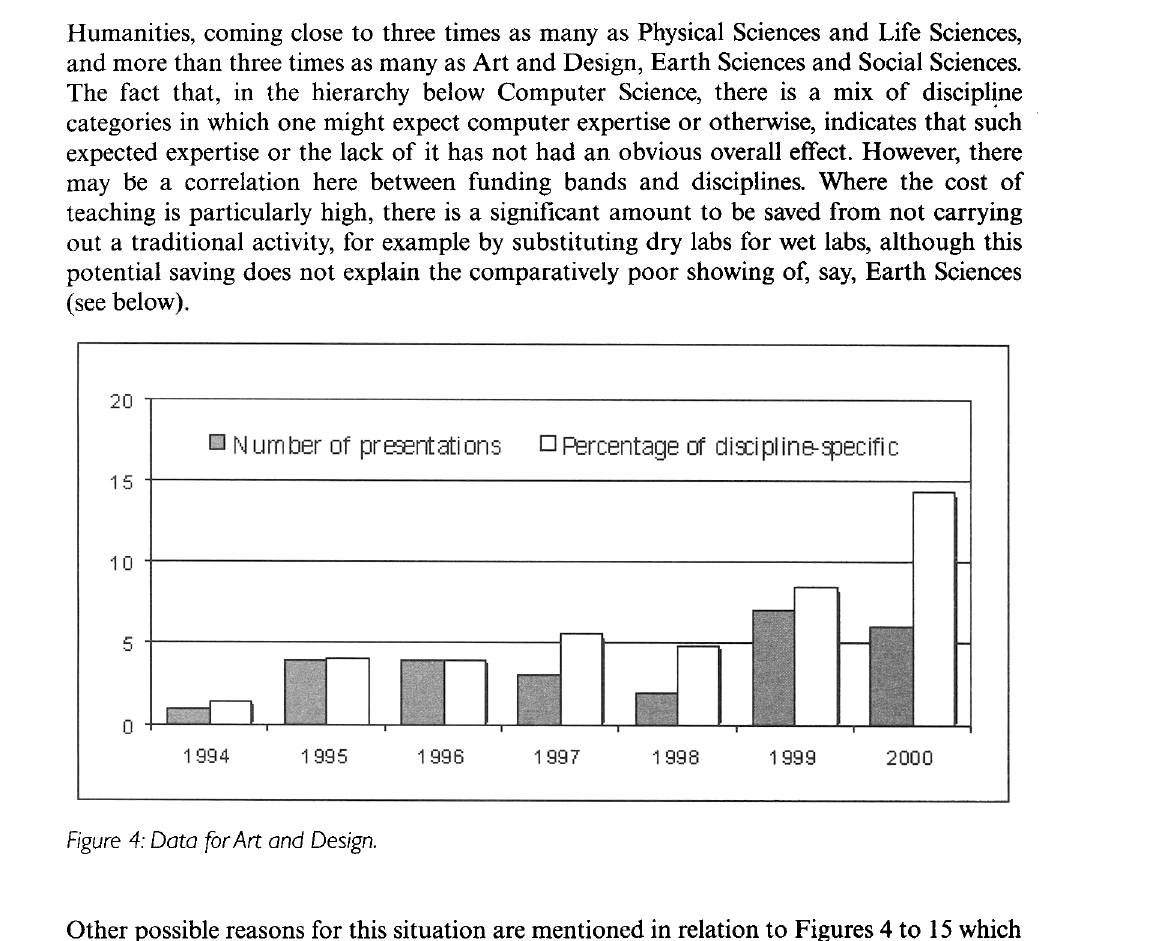
Figure 4: Dato for Art and